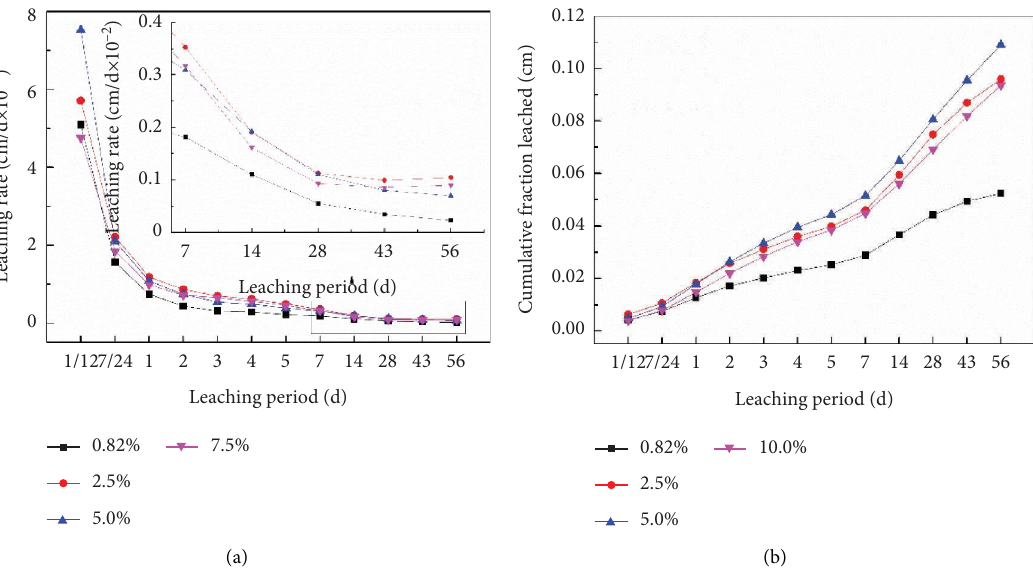
Figure 21: Te leaching curves of Cs + in the SFCM with diferent sodium hydroxide contents at a sodium nitrate concentration of 300g/L: (a) LF; (b)